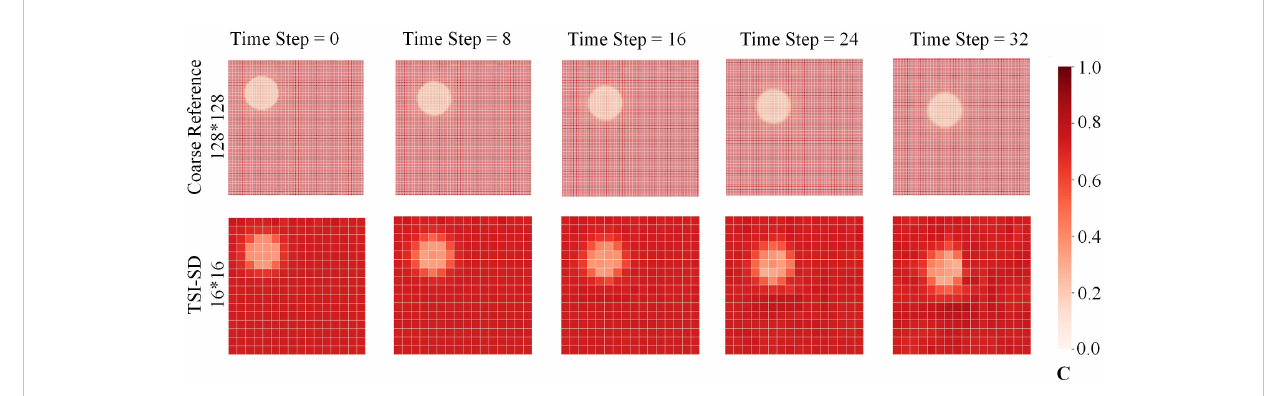
FIGURE 8 The predicted performance of our model in a constant velocity fi eld of v x =1 and v y =1. The fi rst row is the iterative solution of our 128*128 high- resolution solver after 32 time steps, and the second row is the iterative solution of our 16*16 solver after 32 time